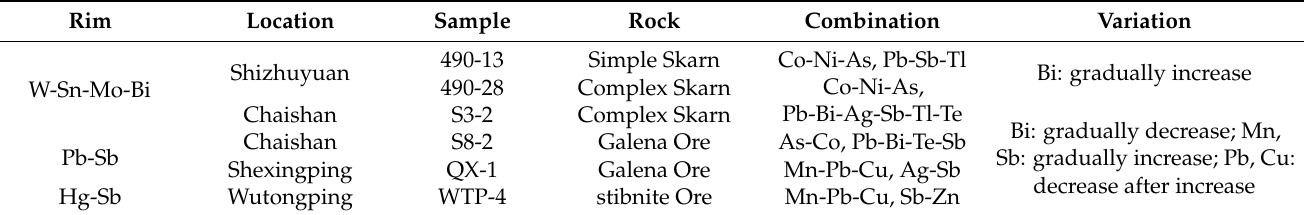
Table 8. Combination and variation of trace elements in pyrites among each